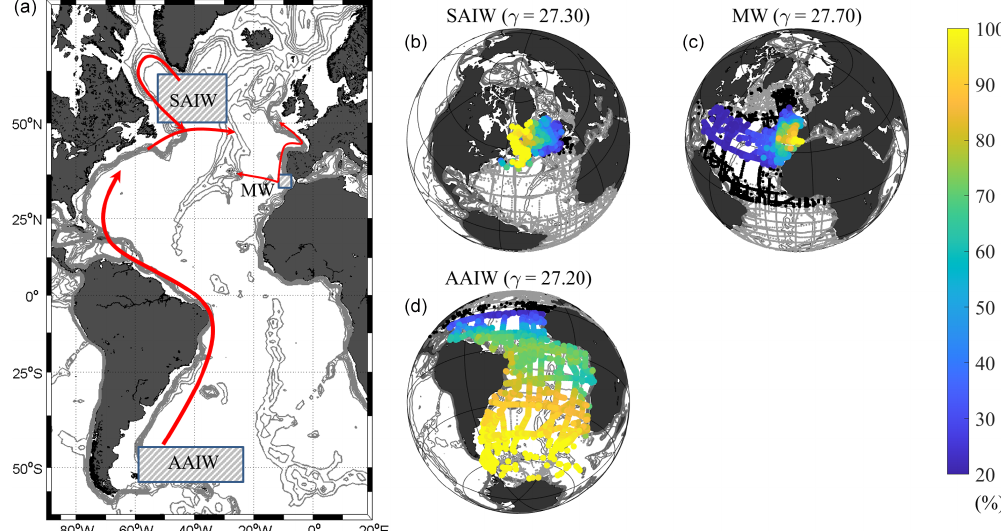
Figure 10. Currents (a) and water masses (b, c, d) in the intermediate layer. (a) The currents (arrows) and the formation areas (rectangular shadows) of water masses in the intermediate layer. (b, c, d) The coloured dots show fractions from 20% to 100% of water masses in each station around the core neutral densities (kgm − 3 ). Stations with fractions less than 20% are marked by black dots, while grey dots show all the GLODAPv2